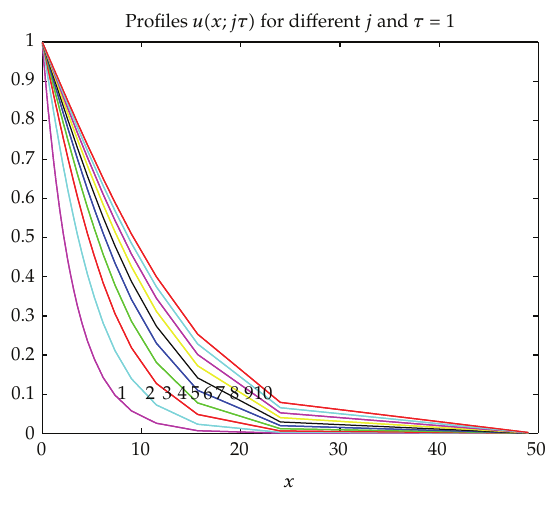
Figure 7: By quasi-uniform